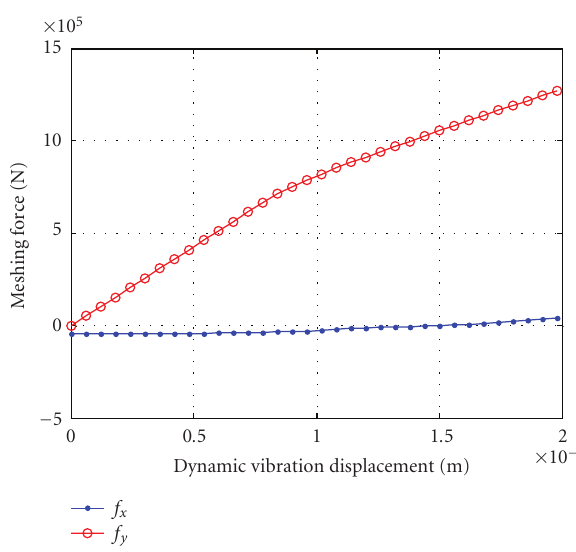
Figure 8: Meshing force versus spline thickness.